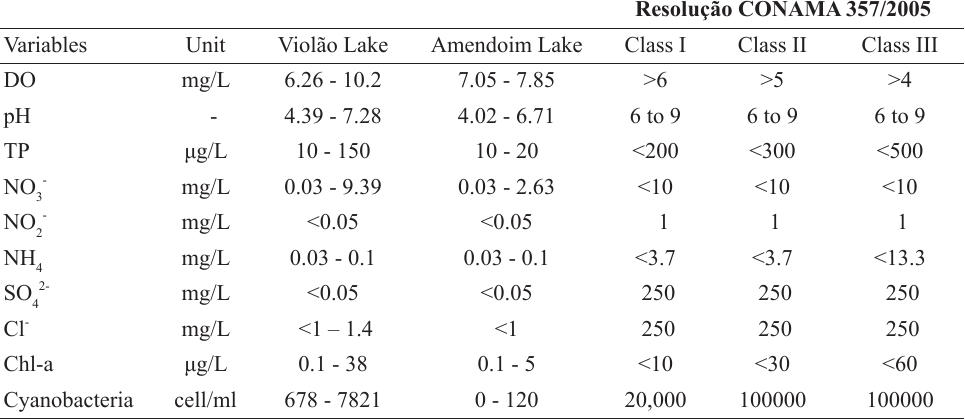
Classification of freshwater bodies according to the CONAMA Resolution No. 357 (CONAMA